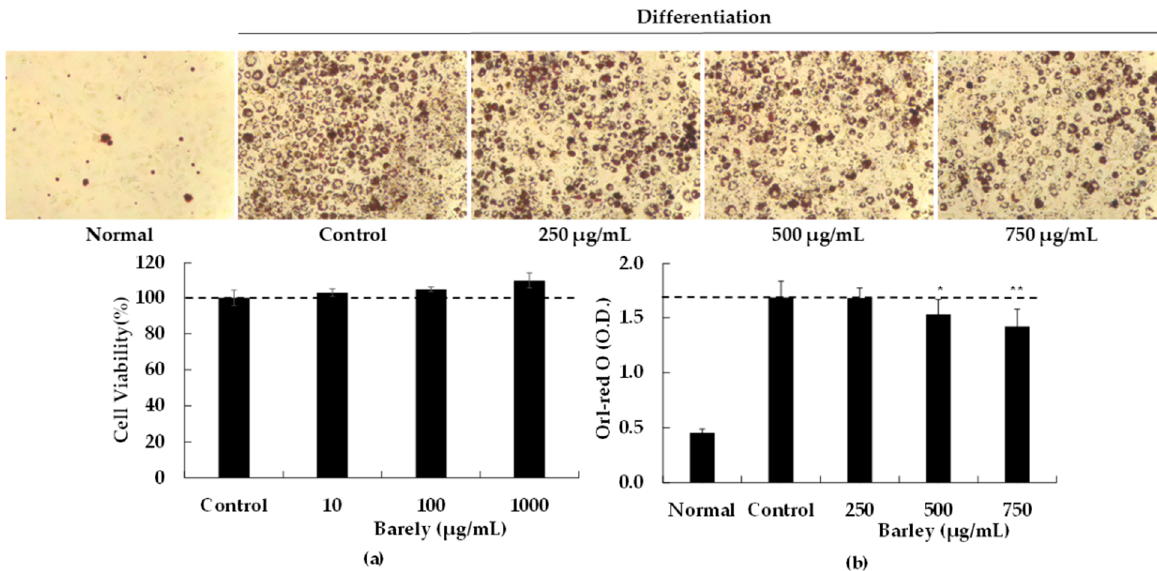
Figure 1. Effects of BEE on the lipid accumulation of 3T3-L1 cells. ( a ): 3T3-L1 preadipocytes cells were seeded at a density of 1 × 104 cells per well in 96-well plates and incubated in culture medium at 37 °C for 24 h to allow attachment. The attached cells were either untreated control or treated with 10, 100, or 1000 µg/mL of BEE at 37 °C for 48 h. After 48 h of incubation. The effects of BEE on cell viability were measured by MTT assay. The data are presented as relative cell viability values. Data are the means ± standard deviation (S.D.) values of at least 3 independent experiments. ( b ): 3T3-L1 preadipocytes were grown and differentiated with the differentiation cocktail in the absence and presence of varying concentrations (0, 250, 500, and 750 µg/mL) of BEE throughout the differ- entiation for 8 days. After 8 days of differentiation, these cells were subjected to Oil Red O staining for control and BEE to compare intracellular lipid accumulation (control: without BEE, normal: no differentiation). The results are expressed as the mean ± S.D ( n ≥ 6). Significantly different from control group (* p < 0.05, ** p < 0.01).